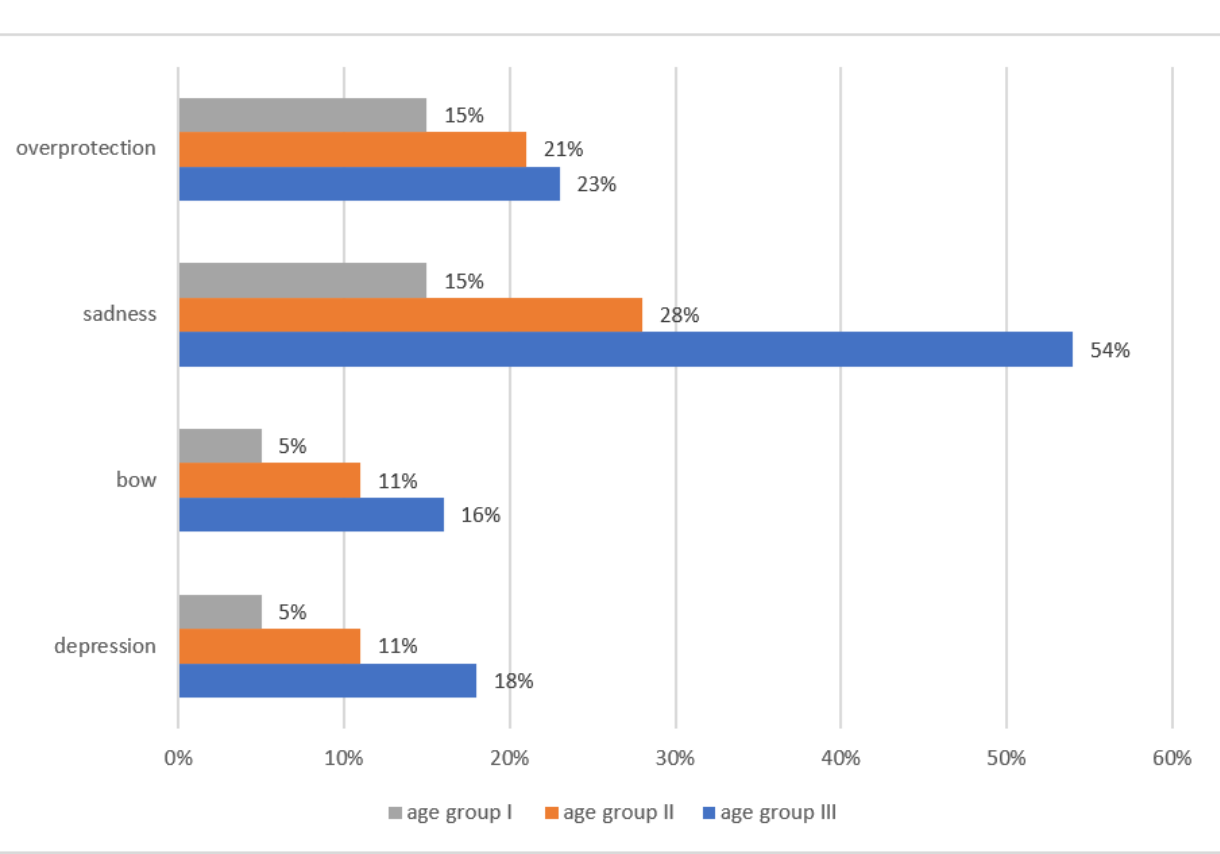
Figure 3. Changes in parents’ behavior noticed by the respondents.